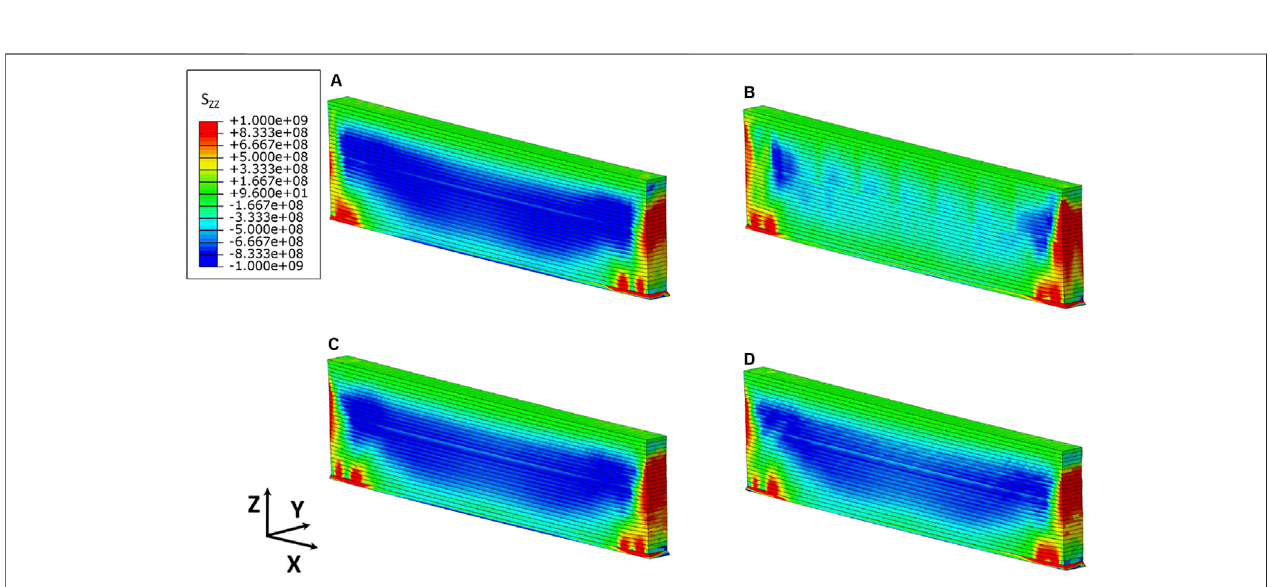
FIGURE13| Builddirectionresidualstress(S ZZ (Pa))comparisonbetweenthefourscanningpatternsdescribed in Figure1(A) Perpendicular, (B) longitudinal, (C) 90 ° rotation, and (D) 45 ° rotation. The residual stresses are shown along a centerline cross section of the part-scale simulations.